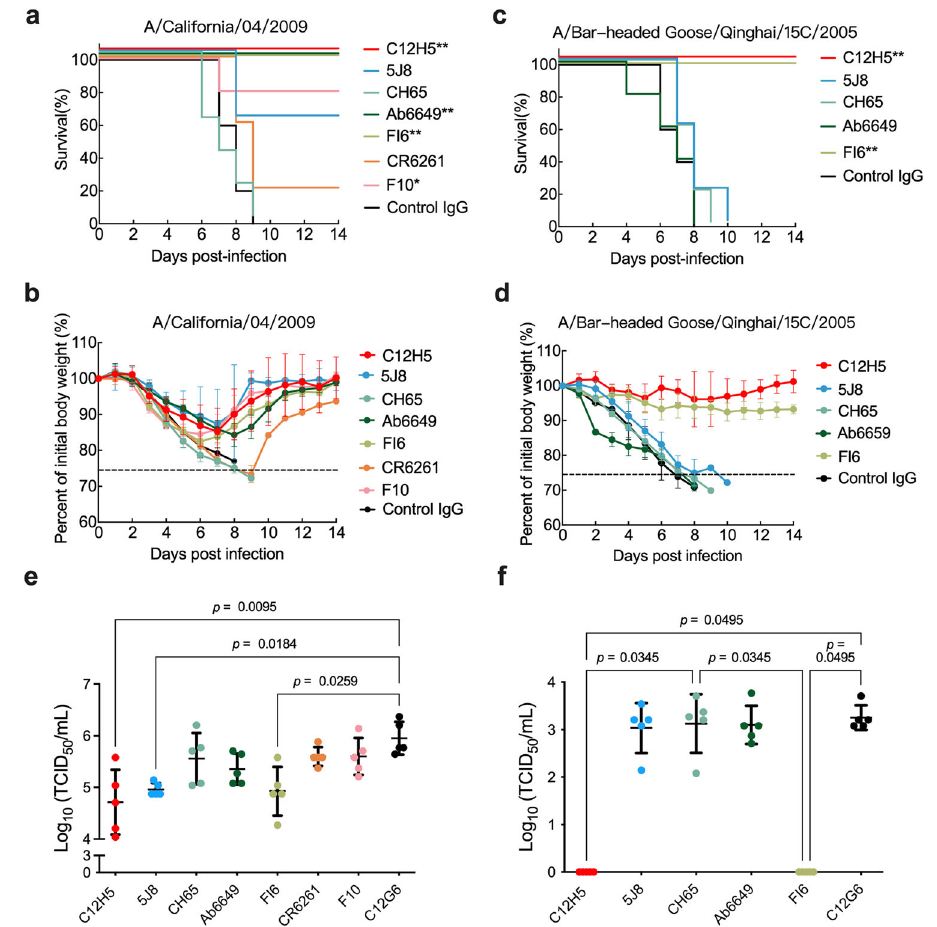
Fig.3|Comparisonoftherapeuticef fi caciesofC12H5andotherbnAbsinmice. Survival curves ( a , c ), body weight changes ( b , d ), and lung virus titers ( e , f ) for BALB/c mice ( n =5 per group) treated intravenously with antibodies (3mg/kg for MA-CA4/2009 virus, 15mg/kg for MA-QH/2005 virus) 24h after lethal challenge. Thebodyweightcurvesre fl ecttheweightsofsurvivingmice;datapertainingtothe micethatdiedafterchallengewereomittedfromthebodyweightdata.Virustiters